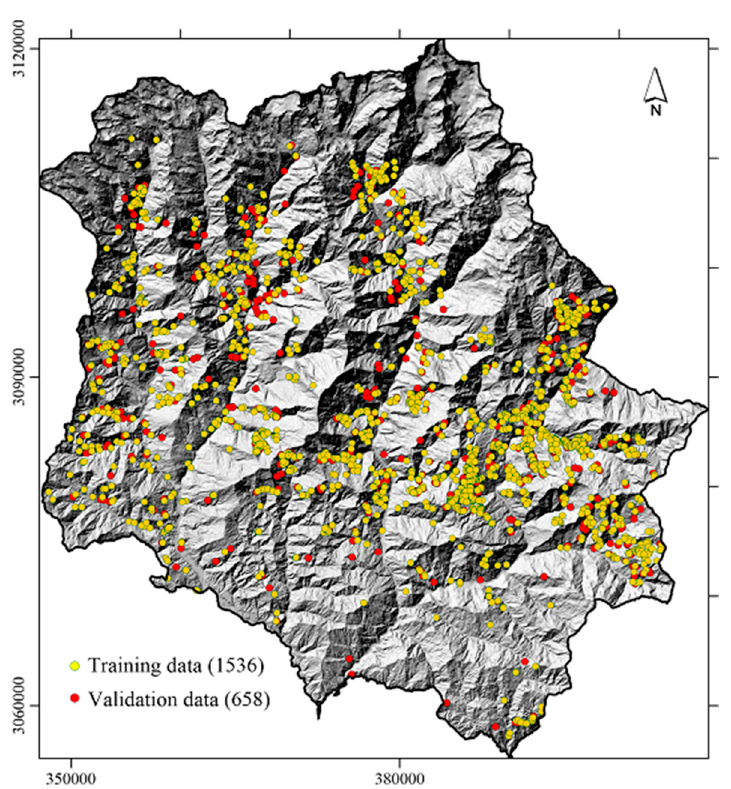
Figure 4. Landslide inventory map.